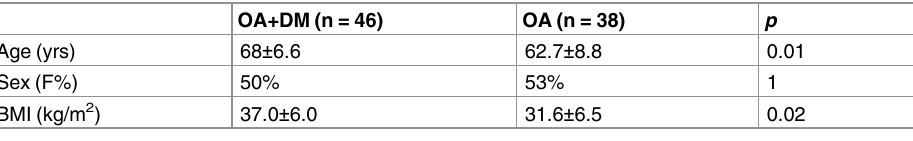
Table 1. Descriptive statistics of the study population *